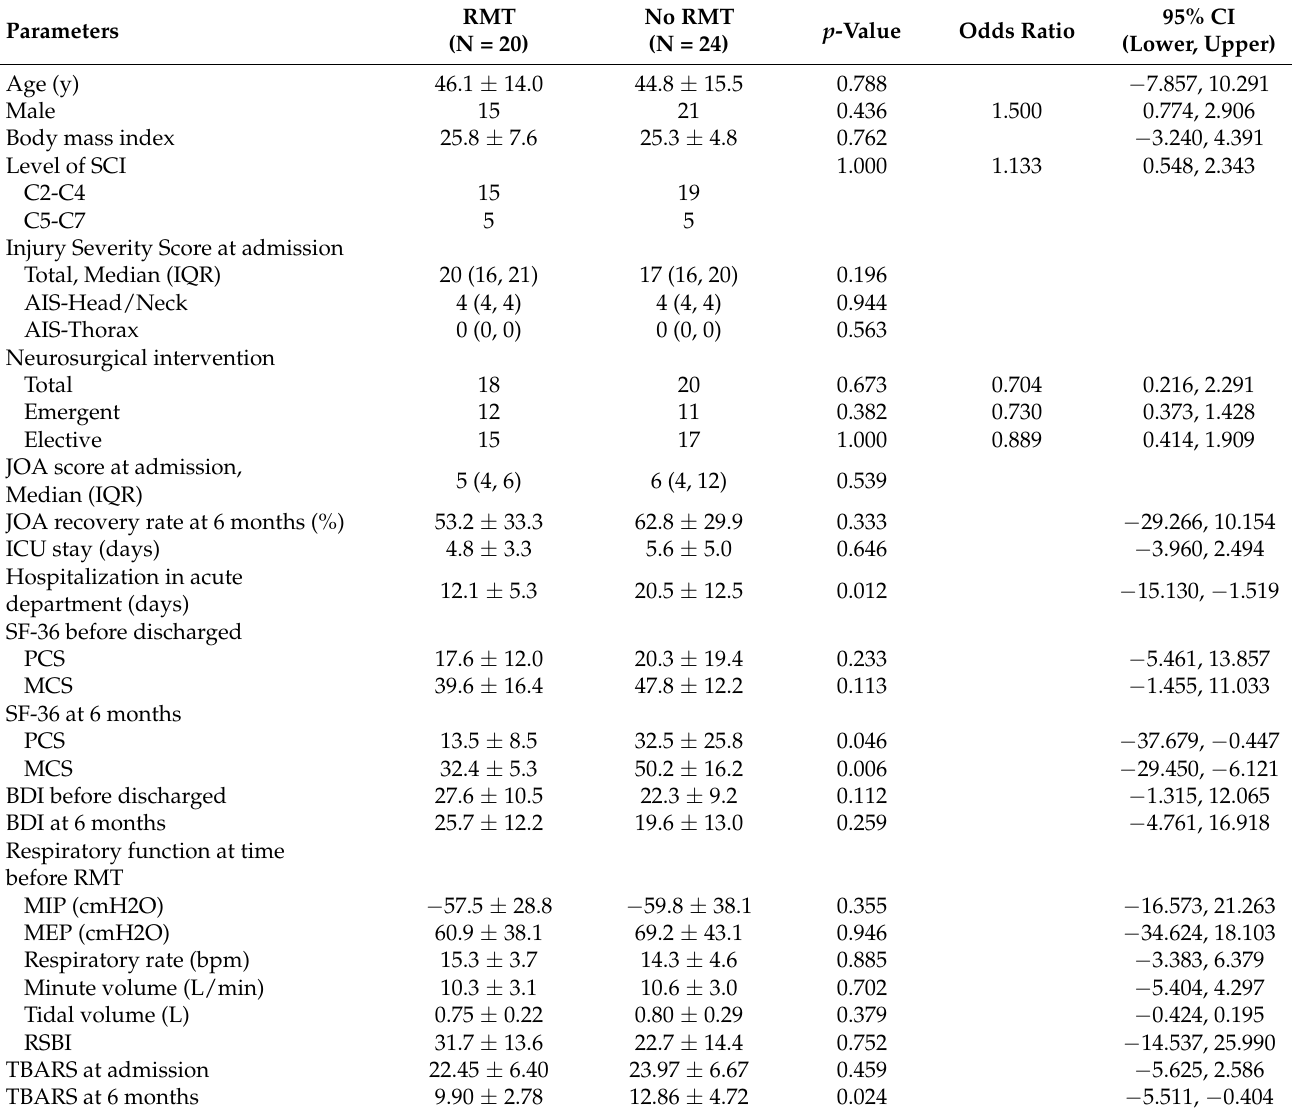
Table 1. Comparison between groups of patients with RMT and without